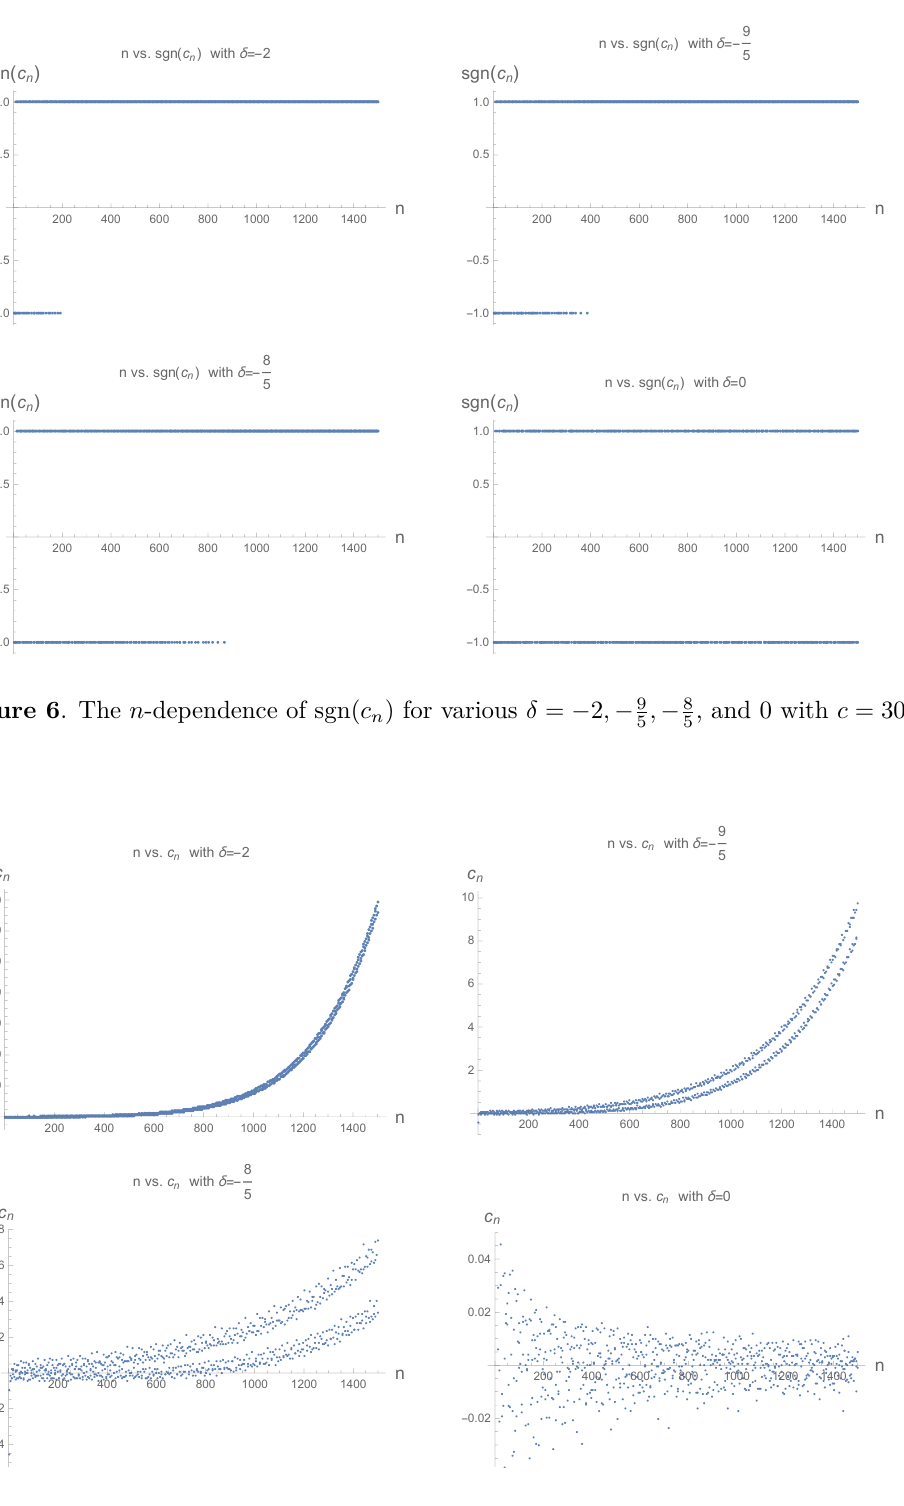
, and 0 with c = 30 , − 8 5 5